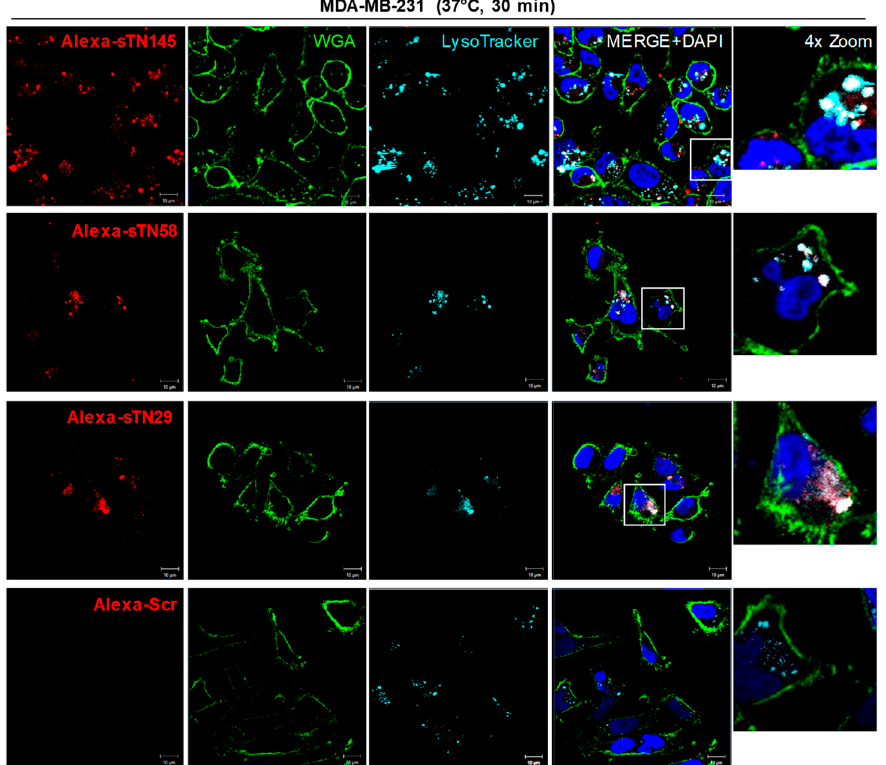
Figure 5. Cell uptake of sTN145, sTN58 and sTN29 aptamers. Representative confocal images of MDA-MB-231 cells incubated for 30 min at 37 °C with Alexa 647-labeled sTN145, sTN58, sTN29 or Scr after treatment with LysoTracker to detect acidic organelles inside the cells. Alexa 647-labeled aptamer, WGA-488, LysoTracker, and nuclei are visualized in red, green, light blue, and blue, respectively. Co-localization results appear white in the merged images. Magnification 63×, 1.0× digital zoom, scale bar = 10 μ m. Inset: 4× digital zoom. At least three independent experiments were performed.